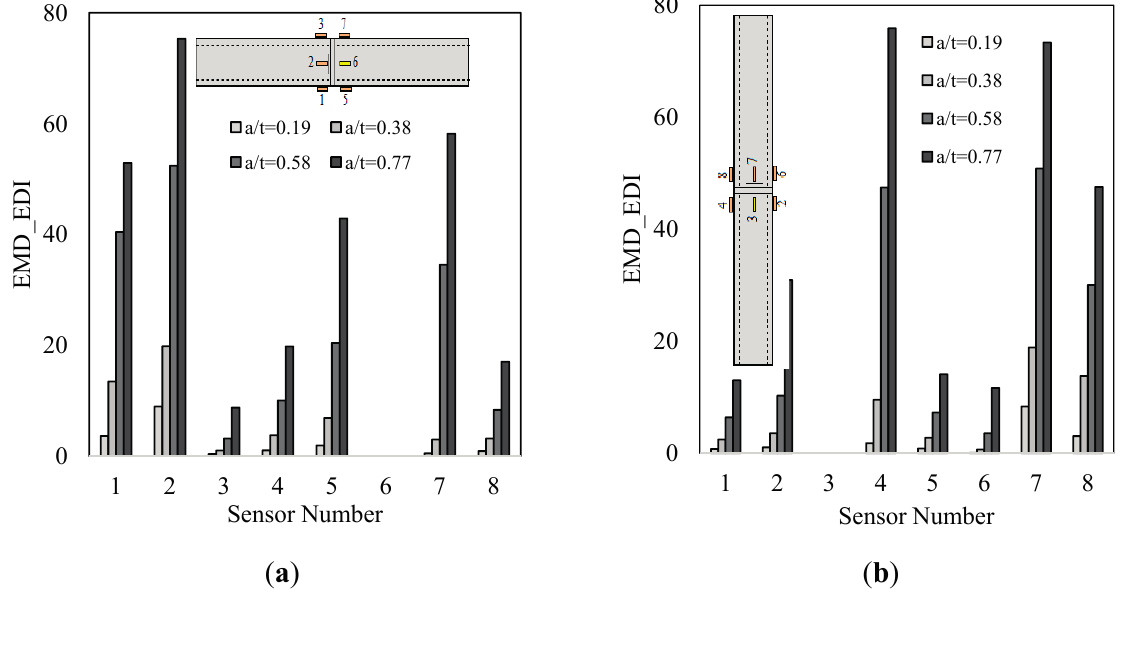
Figure 10. Damage indices obtained from the chirp test: numerical (( a ) and ( b )) and experimental study (( c ) and ( d )). Note that a/t is the ratio of notch’s depth to pipe’s wall